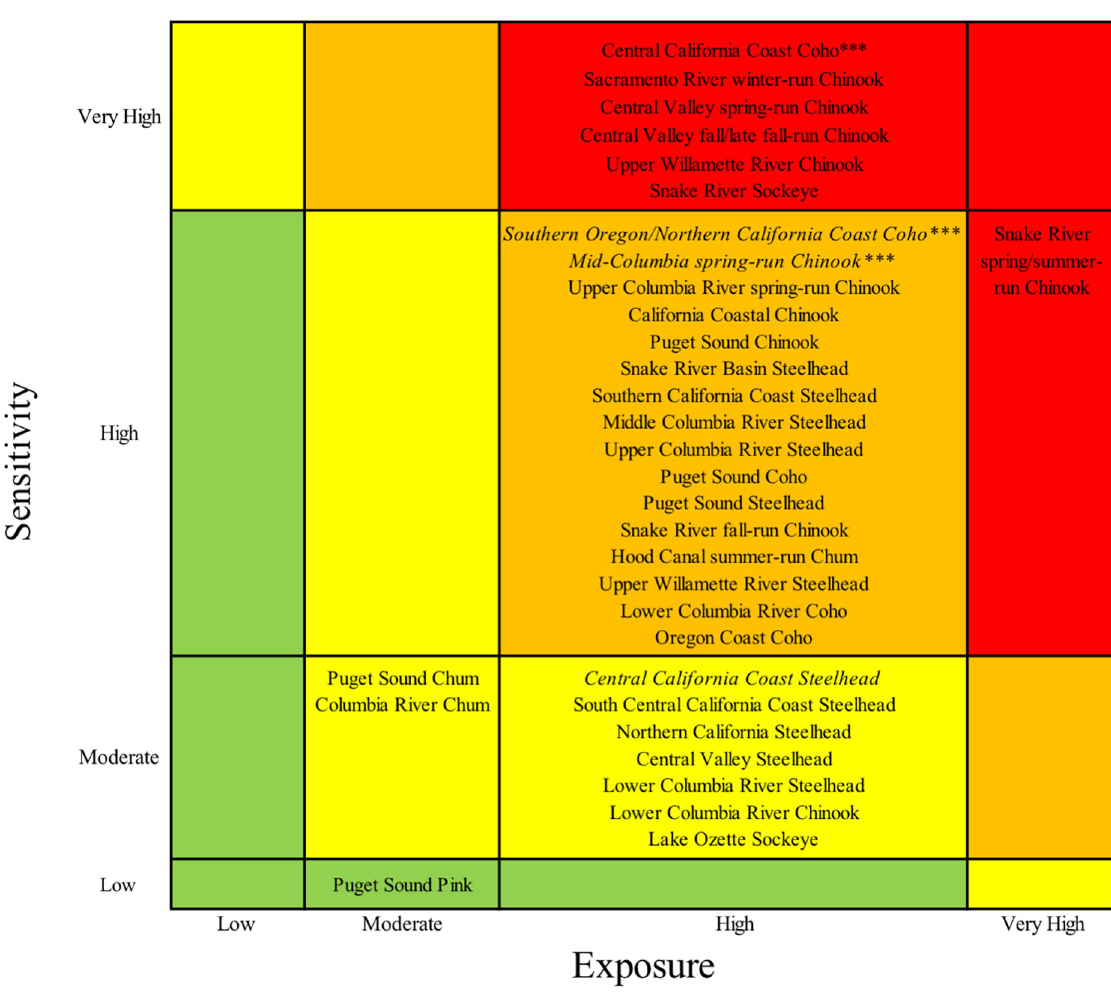
Fig 3. Final cumulative vulnerability ranks. Box colors show final vulnerability rank for each DPS as a product of sensitivity and exposure scores: red indicates very high vulnerability, orange high, yellow moderate, and green low. Uncertainty in final ranks was represented with a bootstrap analysis. Borderline DPSs were those that placed in a higher rank in at least 25% of resampled data. Borderline sensitivity ranks are shown in italic, and borderline exposure ranks indicated with asterisks ( ��� ). All other cumulative vulnerability ranks were considered likely.